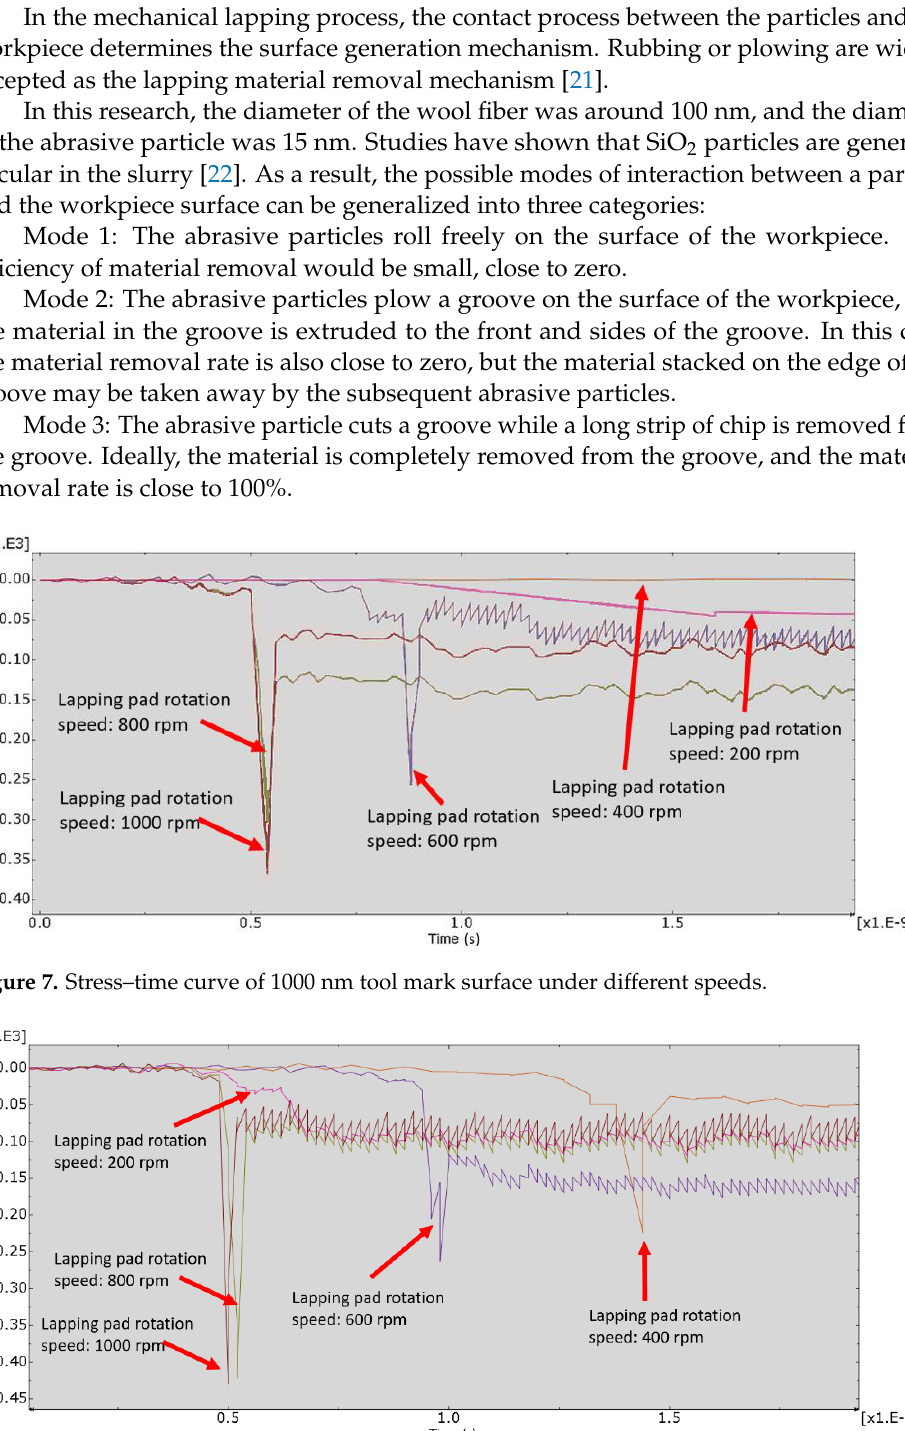
Figure 8. Stress – time curve of 20 nm tool mark under different speeds.